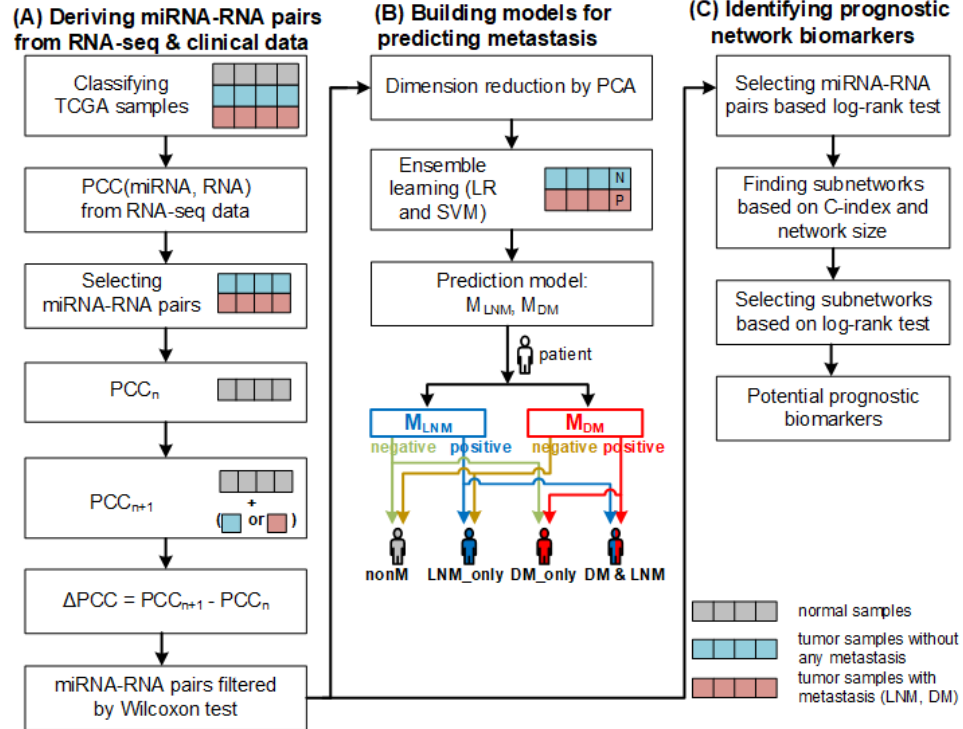
Figure 6. The overall framework of our method. ( A ) Deriving miRNA–RNA pairs based on ∆ PCC from RNA − seq and clinical data. ( B ) Constructing prediction two models for predicting metastasis (LNM and DM) based on differential correlations between miRNAs and their target RNAs and predicting metastasis using the models. ( C ) Identifying prognostic network biomarkers from miRNA– RNA